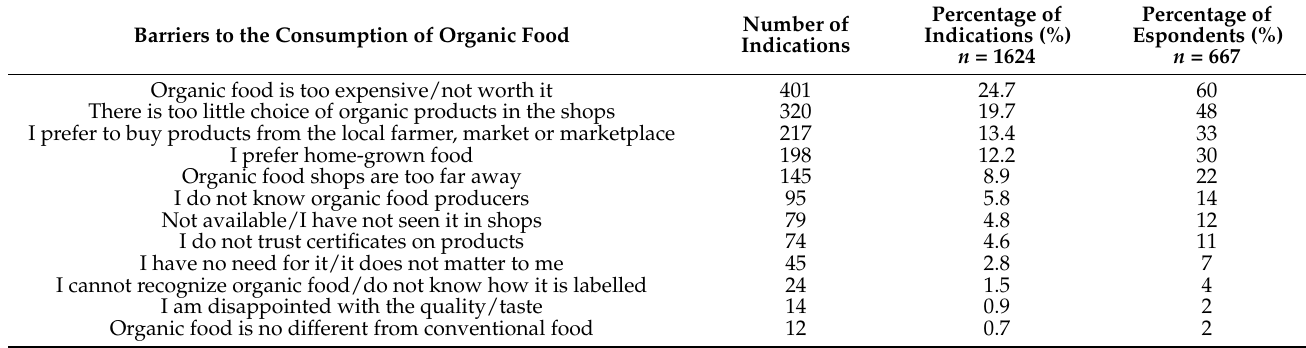
Table 10. Barriers to consumption of organic food for respondents (multiple